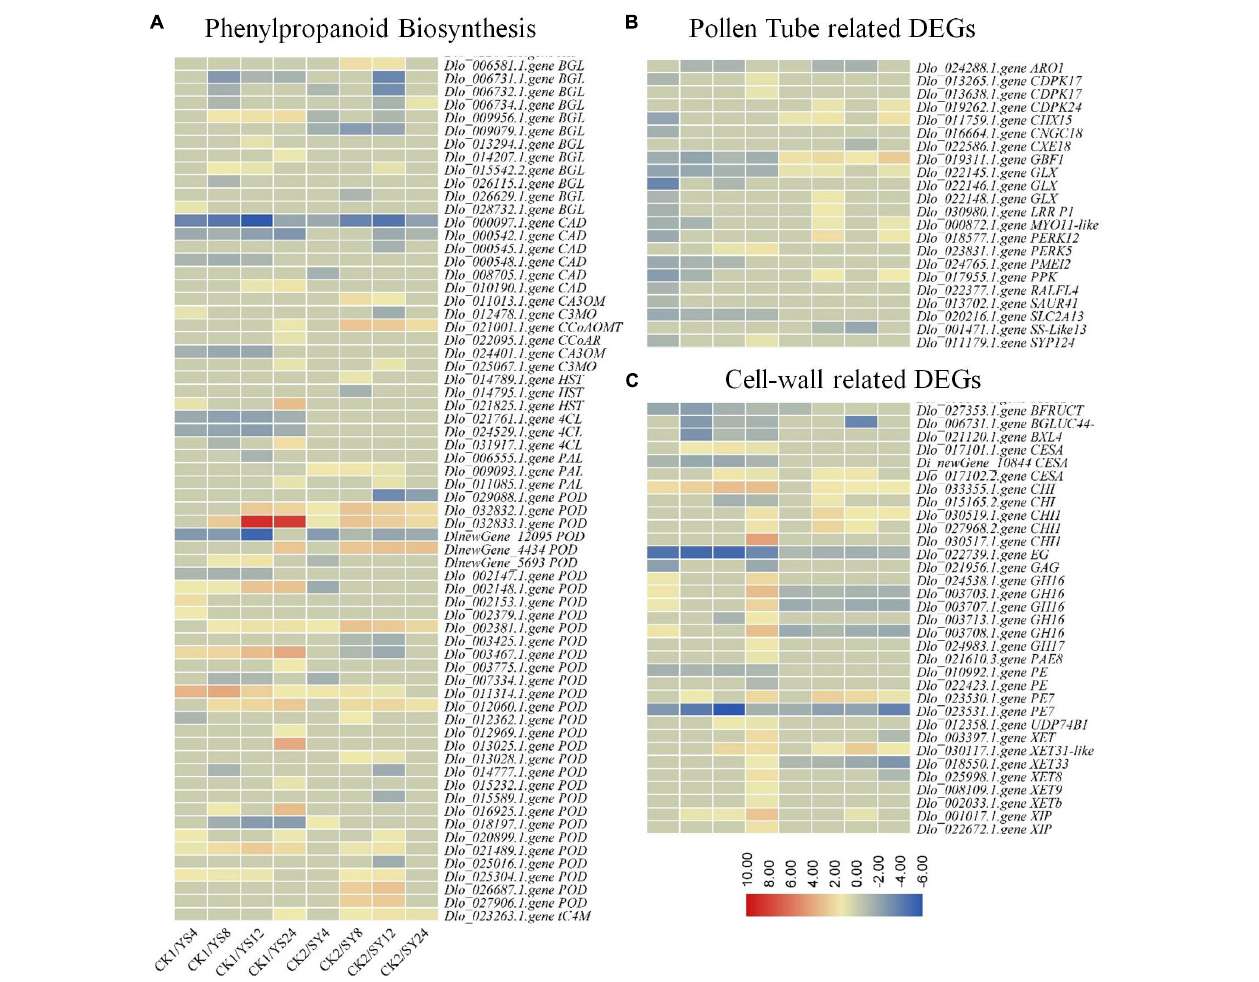
FIGURE 8 | (A) Differential regulation of phenylpropanoid biosynthesis pathway, (B) pollen tube-related, and (C) cell wall-related genes in the CK1 vs. YS series and CK2 vs. SY series. The heatmaps show log2 fold change values of the DEGs. Y, Yiduo; S, Shixia; CK1, Yiduo sepal-pistil before pollination; CK2, Shixia sepal-pistil before pollination. The numbers with treatments represent time after